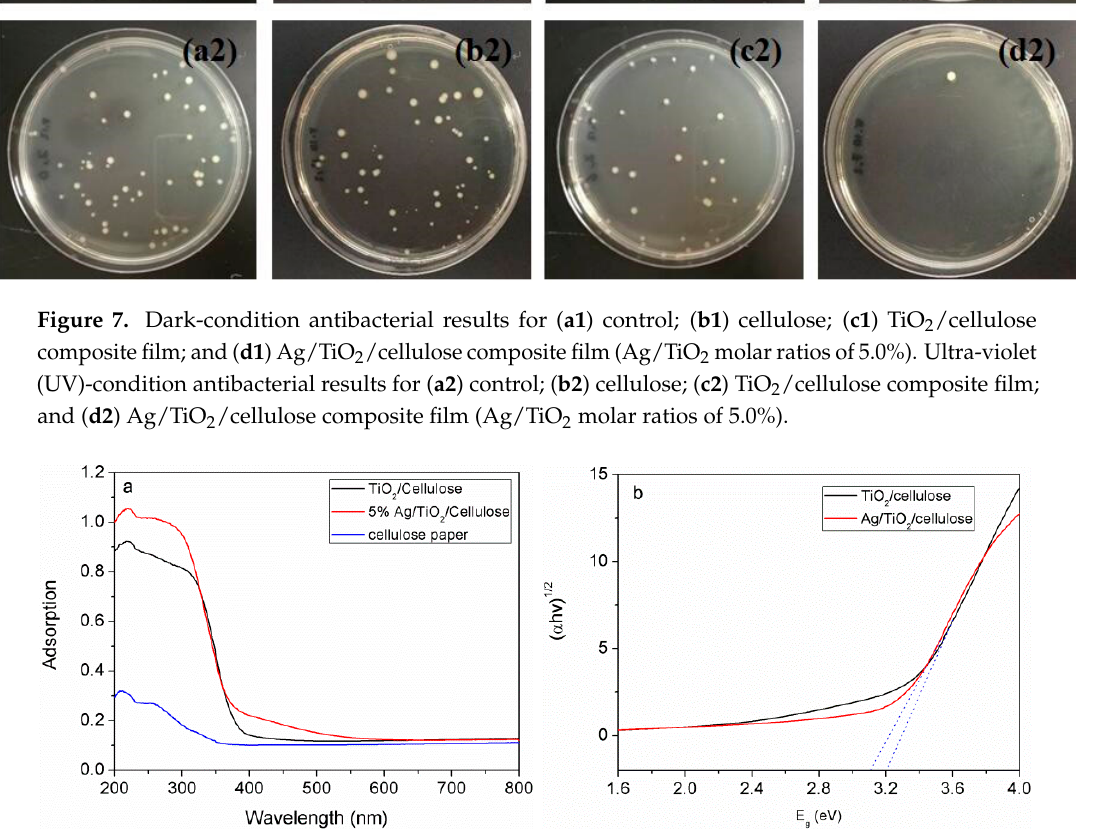
Figure 8. ( a ) UV-vis diffuse reflectance spectra (DRS) of cellulose filter paper; TiO 2 /cellulose; and Ag/TiO 2 /cellulose film. ( b ) The band gap of TiO 2 /cellulose and Ag/TiO 2 /cellulose film.